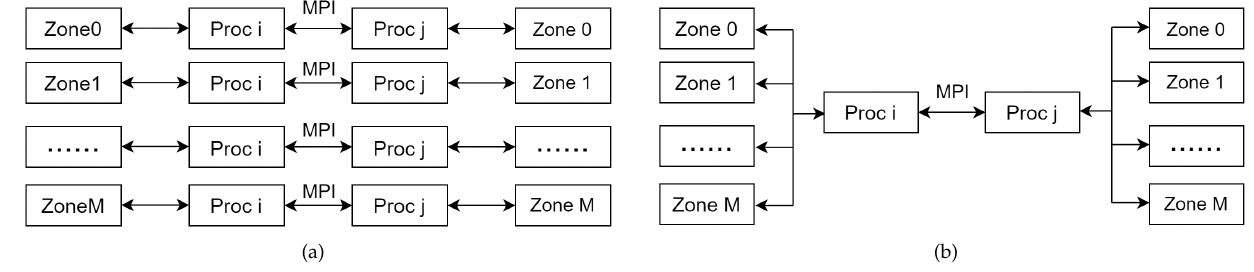
Figure 5. Example of packaging of process data. ( a ) unpacked transfer of data; ( b ) packet transmission of